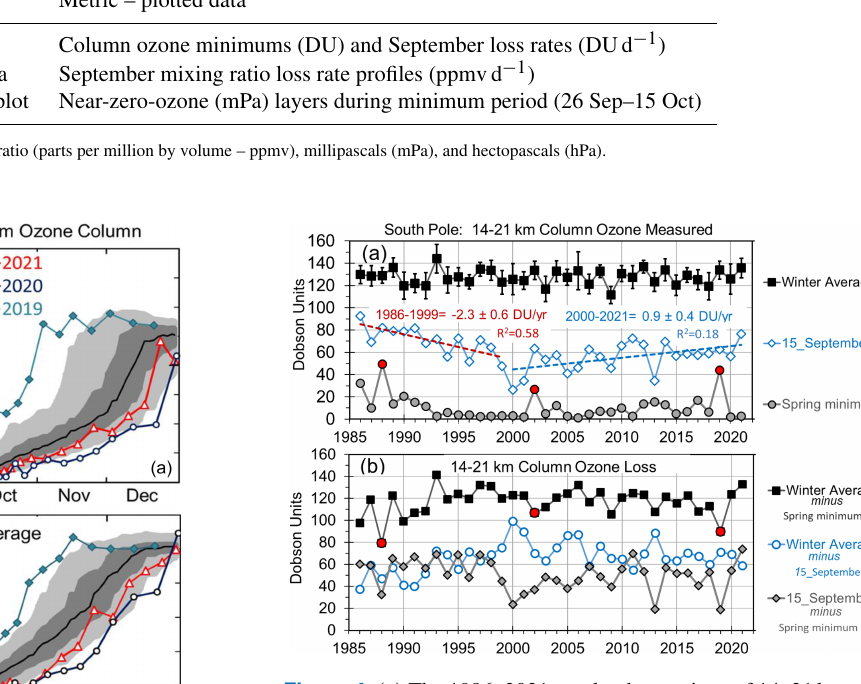
Figure 4. (a) The 1986–2021 yearly observations of 14–21km col- umn ozone over the South Pole showing the winter (15 June–15 August average), 15 September, and the spring minimum ozone in Dobson units (DU). The two dashed lines show the simple regres- sion linear trends and R 2 values for all 15 September measurements before and after 2000. (b) The lower panel shows the difference be- tween the three time series in the upper panel to illustrate maximum column ozone loss, the loss during the first half of September (blue open-circle line), and second half (gray diamond line) of the deple- tion period after 15 September. lines in Fig. 4a were computed by the “least squares”